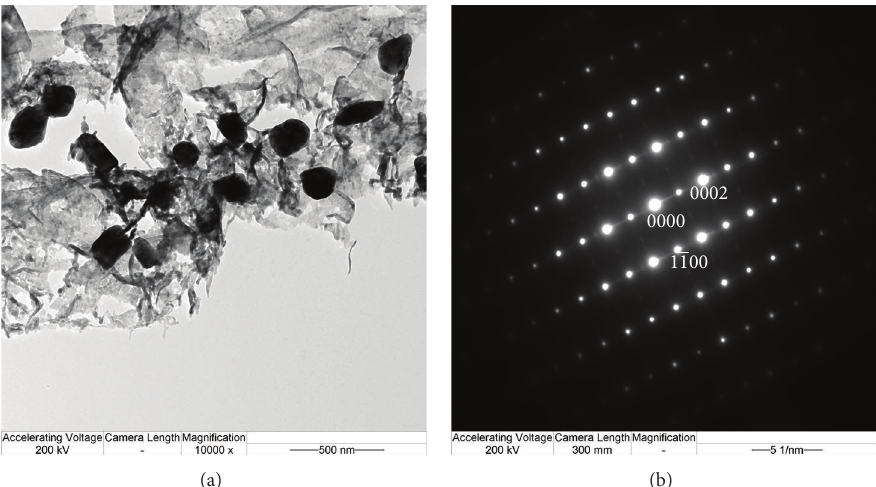
Figure 5: TEM image and electron diffraction pattern showing precipitates aged at 200 ∘ C for 64 h along [1120] 𝛼 zone axis: (a) TEM image; (b) electron diffraction pattern.